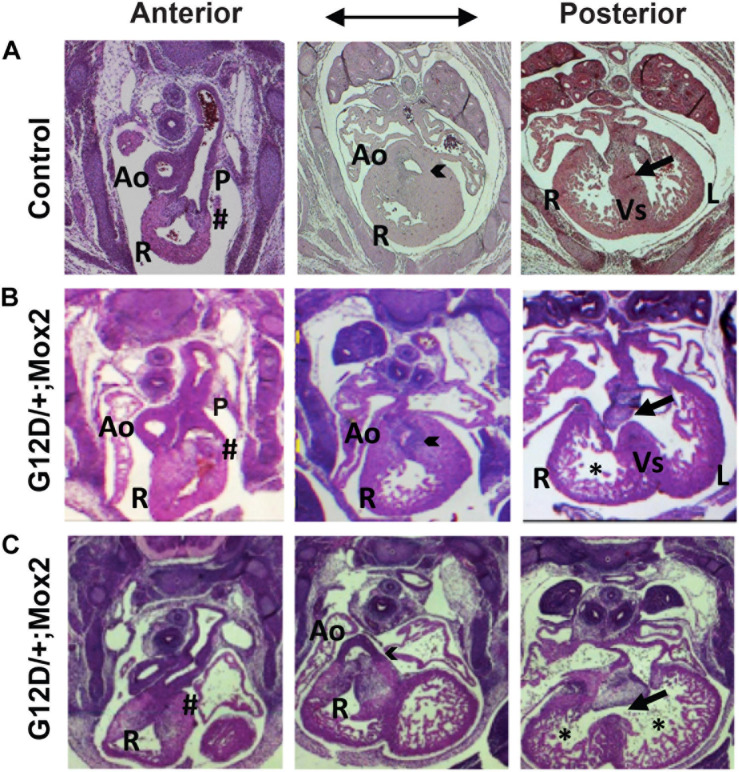
NrasG12D/+; Mox2Cre/+ (G12D/ +; Mox2) embryos exhibit cardiac developmental defects. Representative images of H&E stained transverse sections of control (A) vs. two G12D/ +; Mox2 mutant (B,C) embryos at E13.5. The mutant hearts show VSD (indicated by arrow in right panels B,C), DORV (indicated by arrowhead in middle panels B,C) and the thin ventricular wall (indicated by * in right panels B,C). The pulmonary valves were not remodeled properly (indicated by # in left panels B,C). Ao, Aorta; P, Pulmonary valve; R, Right ventricle; L, Left ventricle; Vs, Ventricular septum.